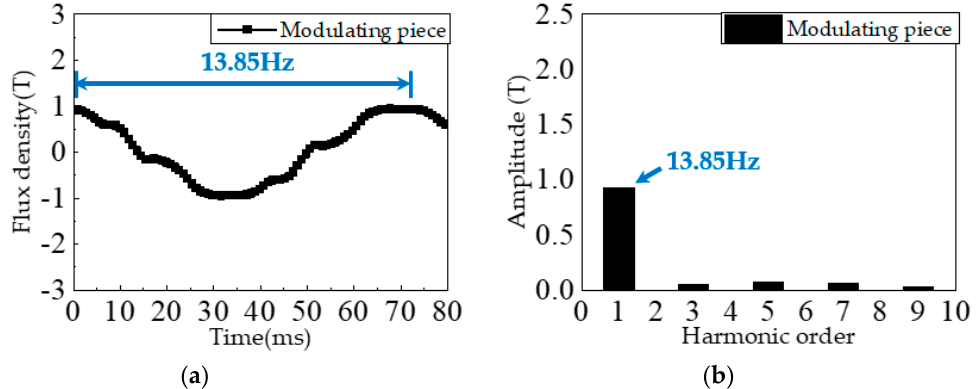
Figure 6. Variation of the radial magnetic flux densities with time at the center of modulating piece. ( a ) Waveform and ( b ) Time harmonic spectra.